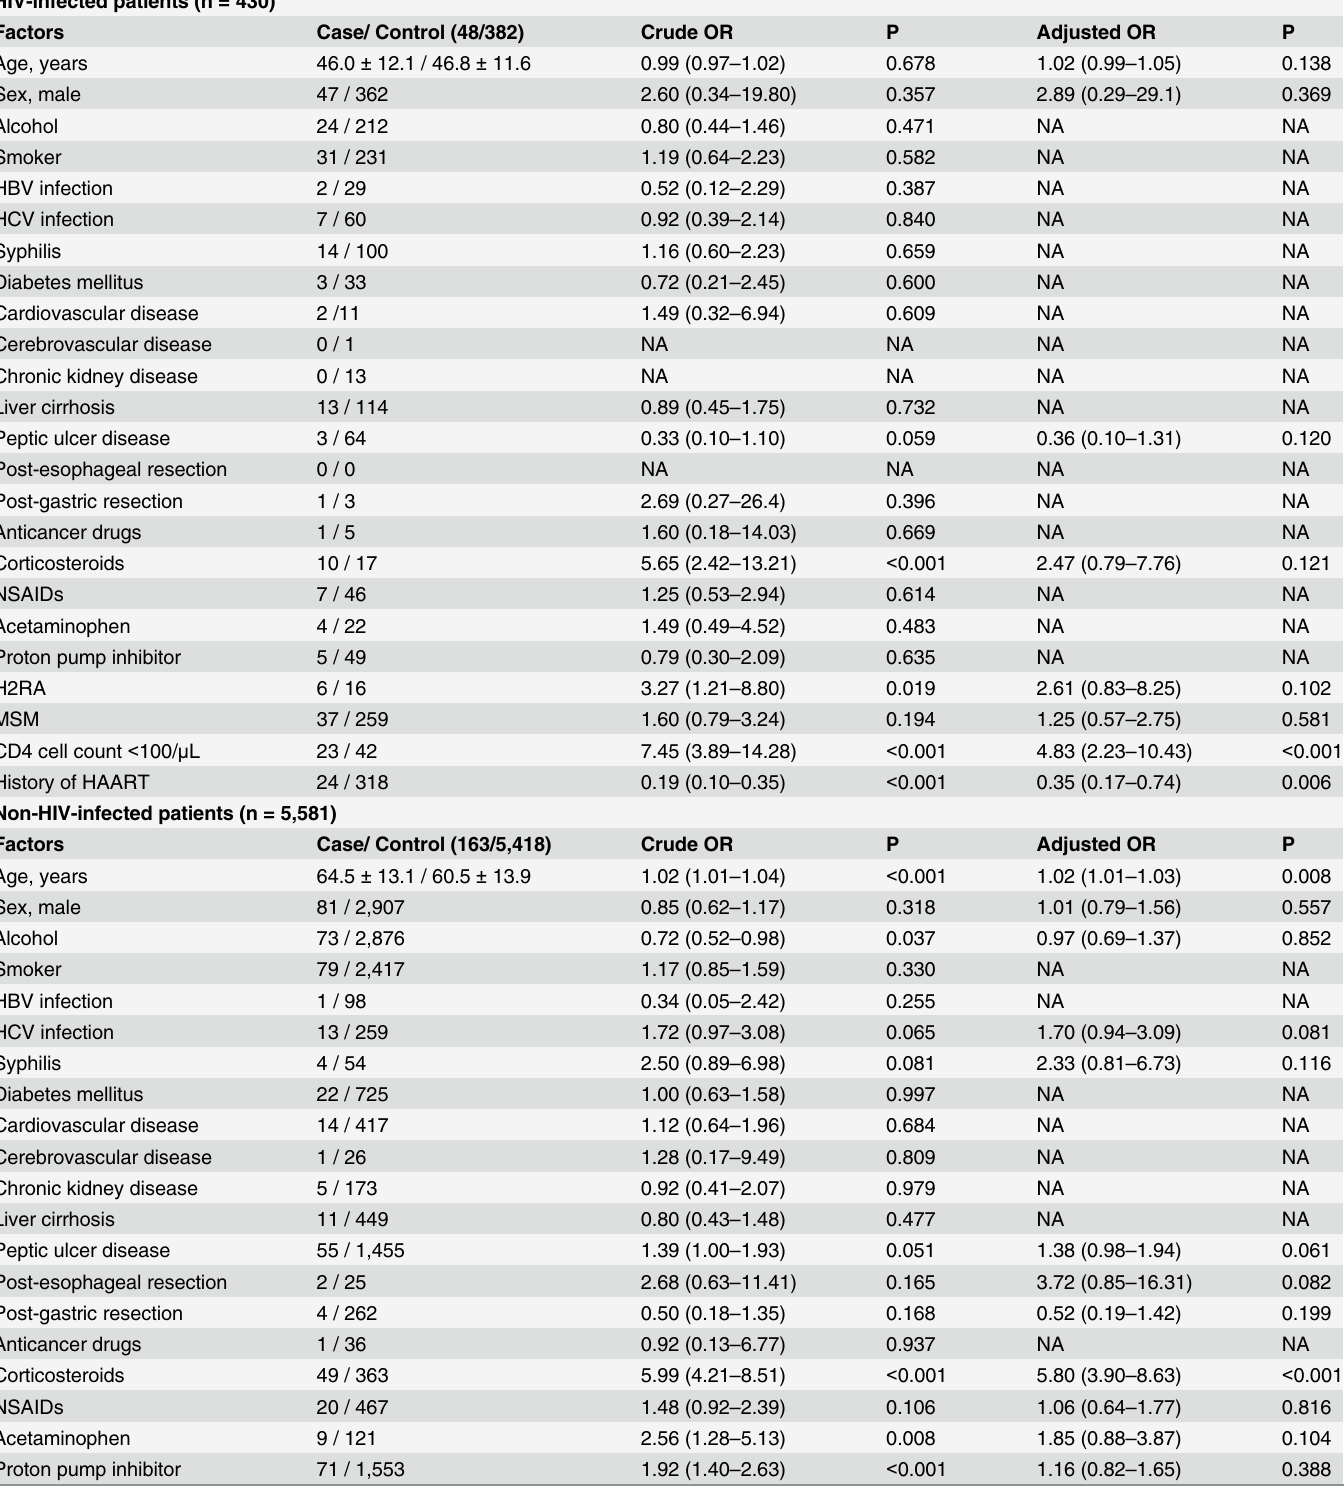
Table 4. Risk factors for candida esophagitis between patients with HIV infection (n = 430) and those without HIV infection (n =